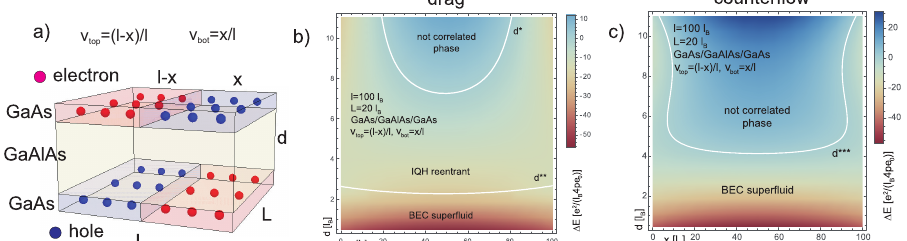
Figure 3. ( a ) The striped sector in the bilayer Hall structure used for trade-off energy of striping cost against the energy gain due to IQHE-reentrant correlation or superfluid exciton BEC state, with marked stripe dimensions. Electrons are shifted to the over-charged stripes, while empty stripes are hole stripes charged by the positive jellium. The structure is mirrored symmetrical with charge change across the barrier of thickness d , which is possible only for a complementary filling of layers, ν top + ν bot = 1 (r other integer), with ν top = x and ν bot = l − x (in the figure, both equal to 1/2). ( b ) The resulted phase diagram, l l versus barrier thickness d and the imbalanced complementary filling pattern (cf. Figure S2) with ν top = x , for the static or drag configuration found by the MMC simulation in GaAs/GaAlAs/GaAs l bilayer structure. ( c ) The phase diagram for the same system at the counterflow configuration, when the IQHE-reentrant state is completely